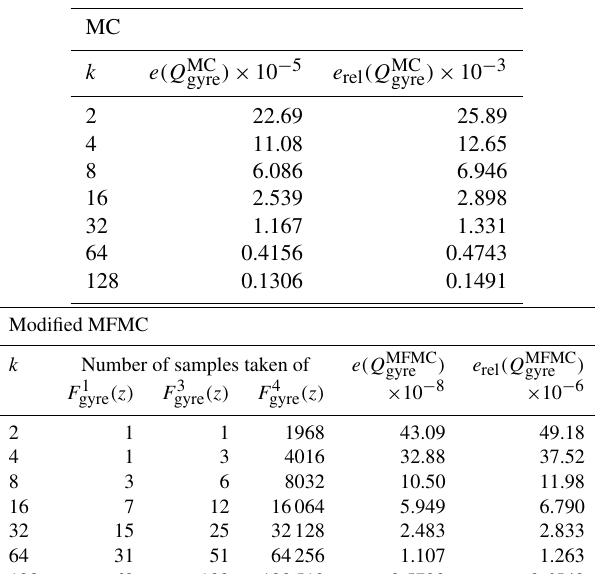
Table 2. Results of the wind-driven barotropic gyre test with per- turbed initial velocities for budgets B = 2 k C 1 equivalent to 2 k highest-fidelity runs.